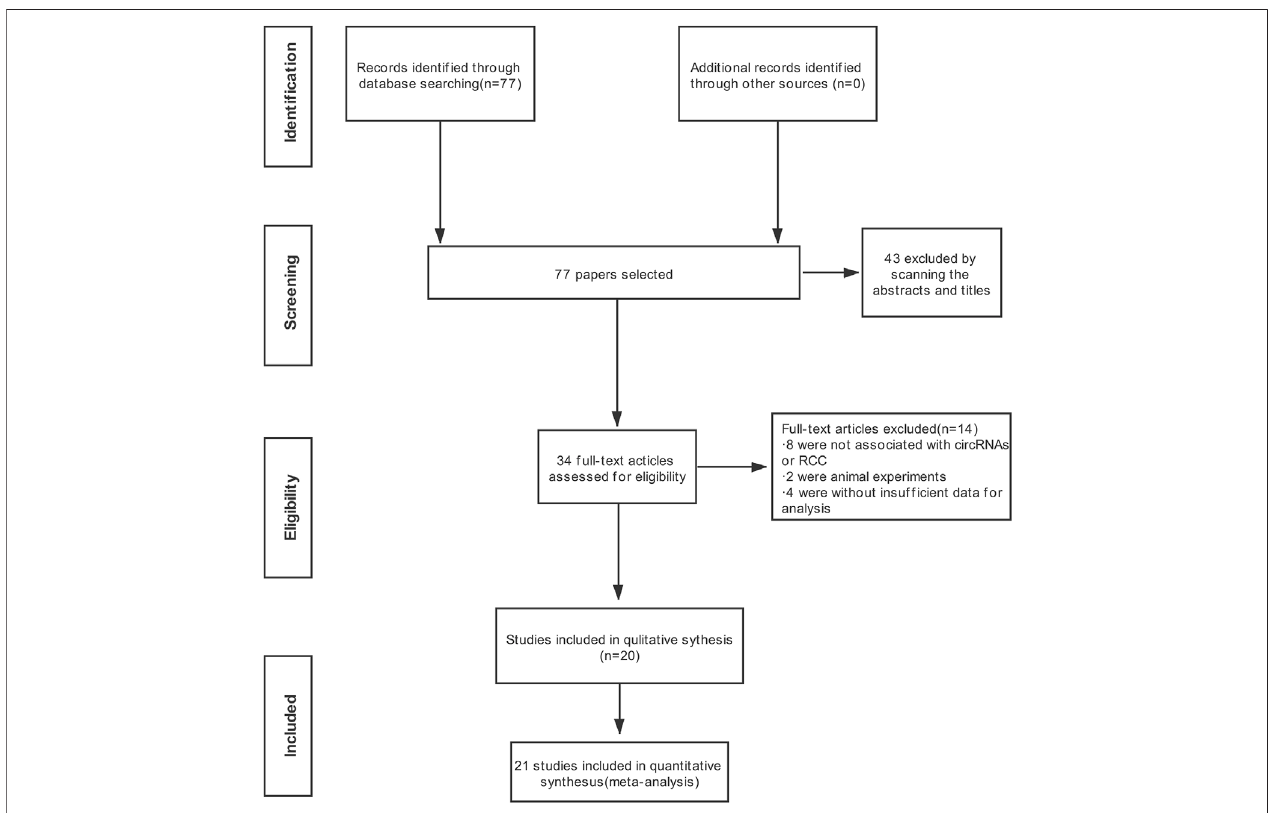
FIGURE 1 | Flow chart demonstrating the study selection